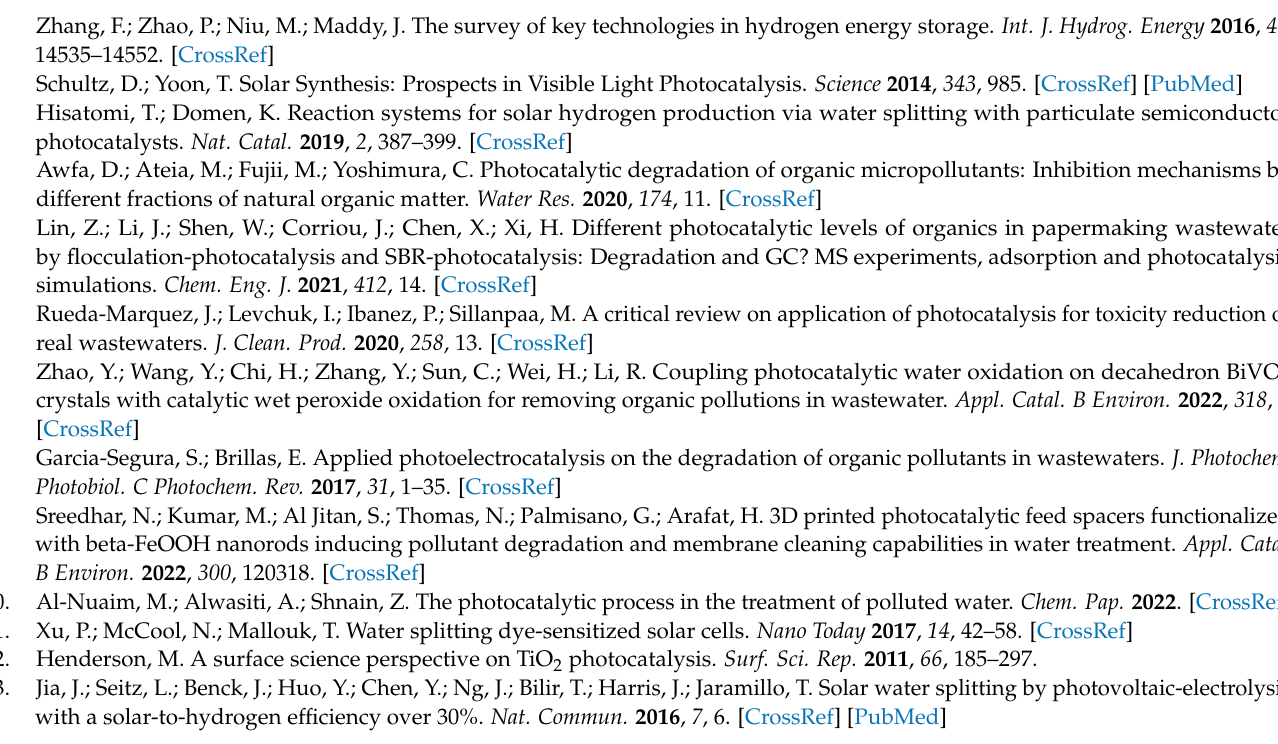
times; Figure S7 Photoresponse current mapping of WO 3 films at different reaction times; Figure S8 Trend of current density at 1.23V vs. RHE for WO 3 films at different reaction times; Figure S9 LSV curves of WO 3 films prepared at different reaction temperatures under 100 mW · cm -2 light; Figure S10 Impedance diagram of WO 3 films at different temperatures; Figure S11 XRD patterns of WO 3 films prepared at different ethanol dosages; Figure S12 LSV curves of WO 3 prepared at different ethanol dosages under 100 mW · cm -2 light; Figure S13 Impedance diagram of WO 3 films with different ethanol dosages; Figure S14 UV-Vis absorptions spectra (A) and calibration curve (B) used for calculation of methylene blue staining